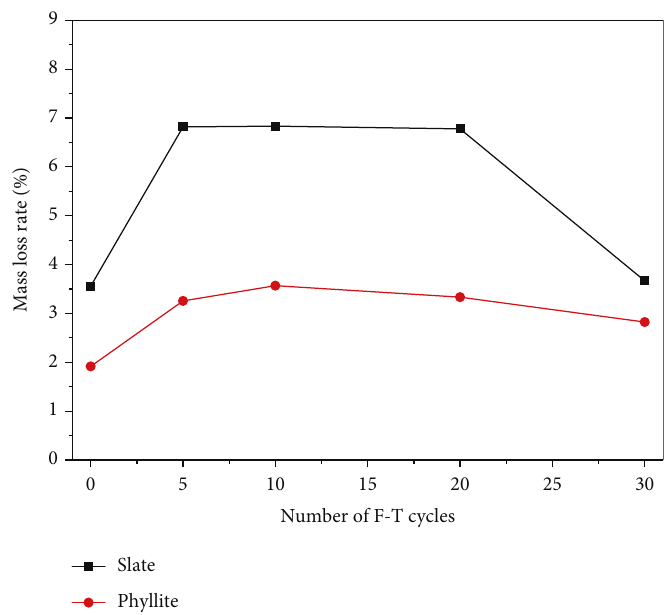
Figure 6: Relationships between mass loss rate and number of F-T cycles of two low-grade metamorphic